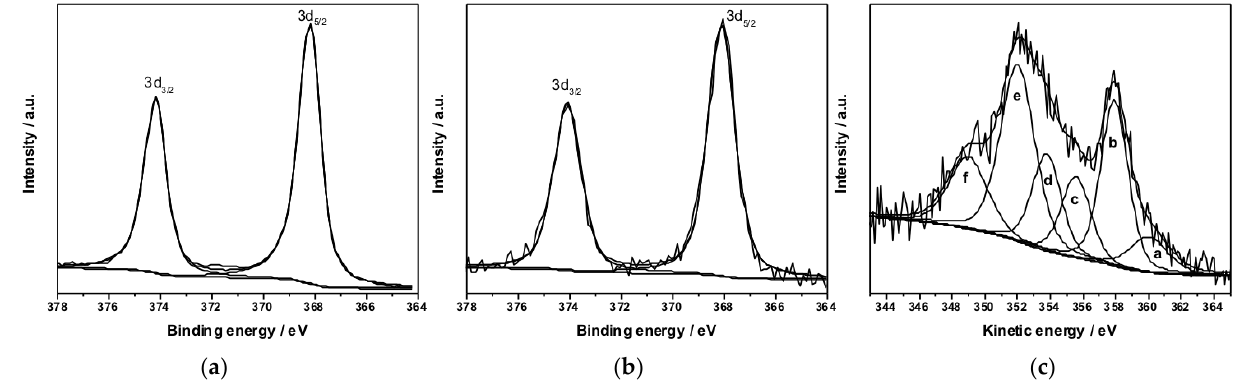
Figure 10. Ag3d XP deconvoluted spectra relevant to: ( a ) F2Ag and ( b ) F3Ag. ( c ) AgM 4,5 N 45 N 45 region relevant to F2Ag films.